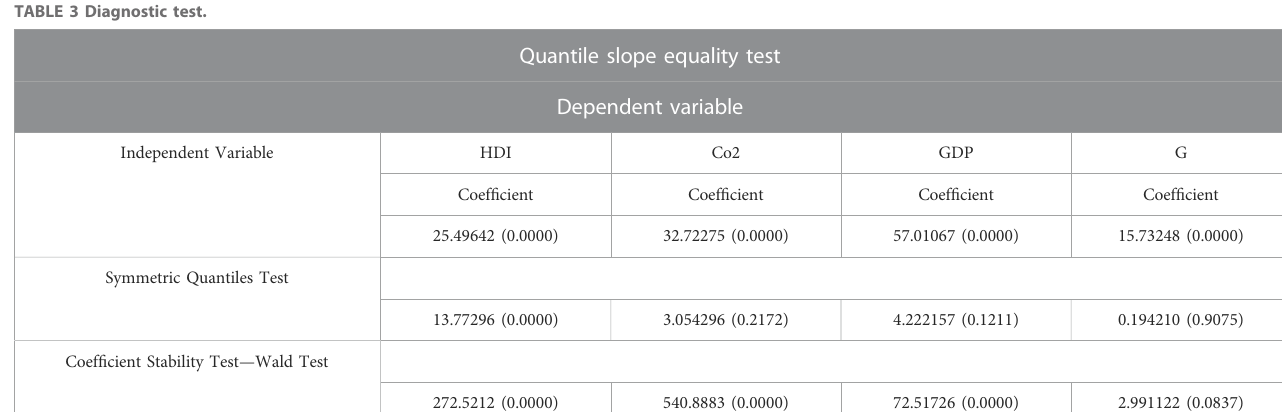
TABLE 3 Diagnostic